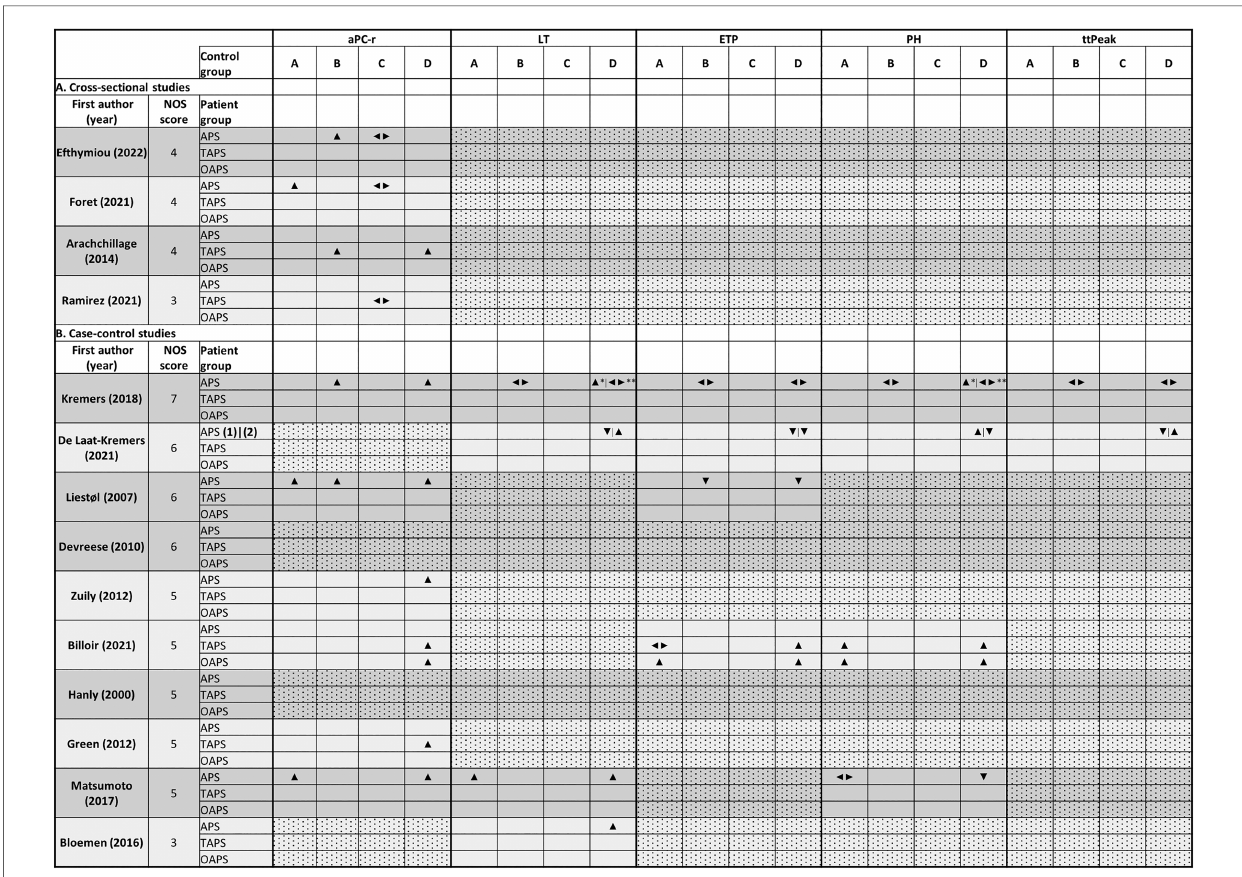
FIGURE 2 Effect direction plot comparing different outcomes between patient groups and control groups. Explanation: ▴ : increased in patient population compared to control population; ▾ : decreased in patient population compared to control population; ◄► : no signi fi cant difference between patient and control population. Control populations: ( A ): antiphospholipid antibody carriers; ( B ): thrombotic controls and control patients on vitamin K antagonist therapy; ( C ): autoimmune disease control group; ( D ): presumably healthy controls. *Thrombin generation with 1 pM TF, **5 pM TF; (1) developmental cohort, (2) validation cohort. Abbreviations: aPC-r, activated protein C resistance; APS, antiphospholipid syndrome; ETP, endogenous thrombin potential; LT, lag time; NOS, Newcastle-Ottawa Score; OAPS, obstetric APS; PH, peak height; TAPS, thrombotic APS; ttPeak, time to